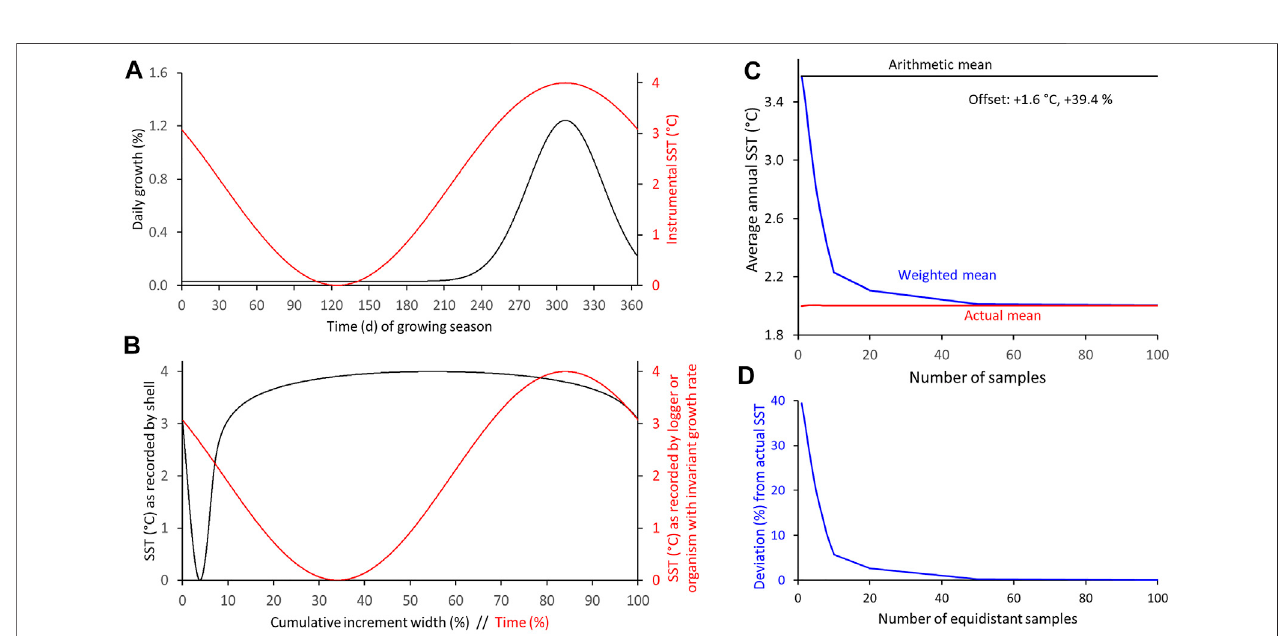
FIGURE 8 | Numerical simulation of differences between arithmetic and weighted annual means computed from intra-annual proxy-SST assuming main growing season (fast growth) is limited to about 5 months, shell growth and SST curves are in phase and both have symmetrical shape. (A) Modeled seasonal shell growth and SST. (B) SST as recorded by model shell and logger. (C,D) Arithmetic and weighted annual proxy-SST in comparison to actual SST mean. With increasing sample resolution, the weighted mean agrees better with the instrumental SST average (C) : absolute values; (D) : relative values.